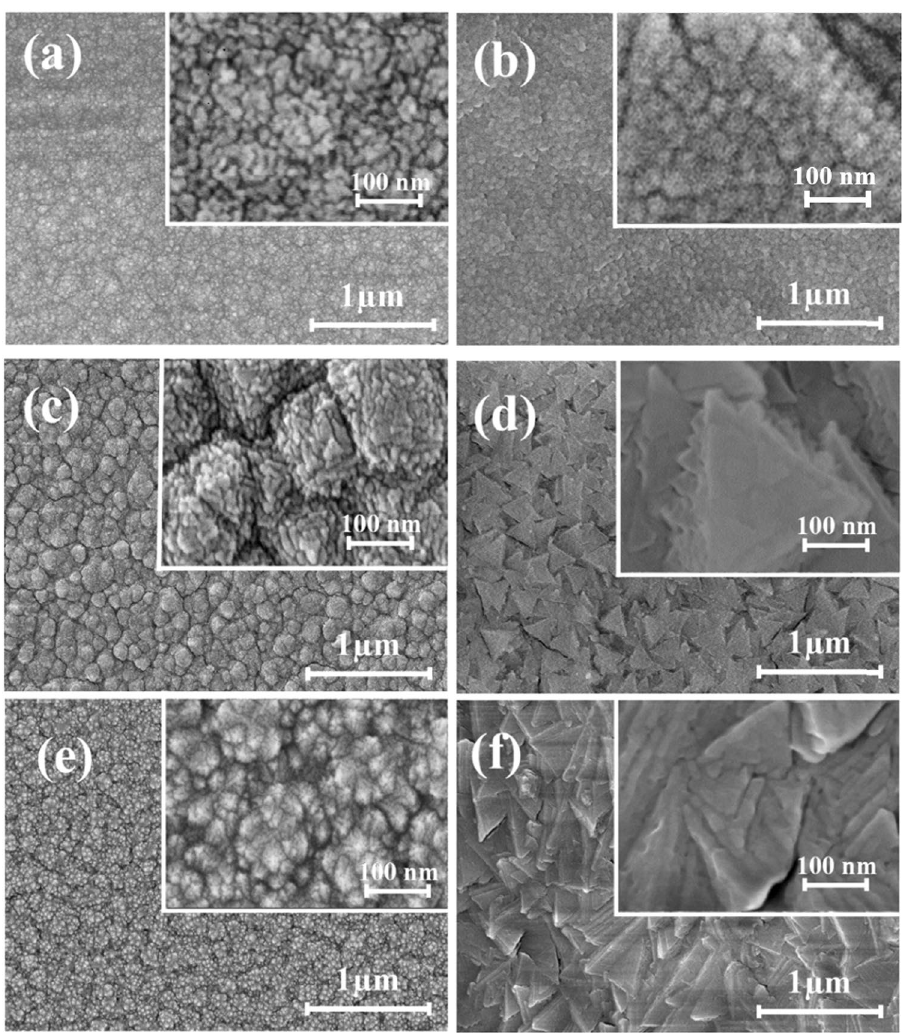
Figure 6. SEM Surface morphology of thin film with low and high magnification at the temperatures of 100 °C ( a , b ), 300 °C ( c , d ) and 500 °C ( e , f ) grown over quartz ( a , c , e ) and anode ( b , d , f ) substrates.